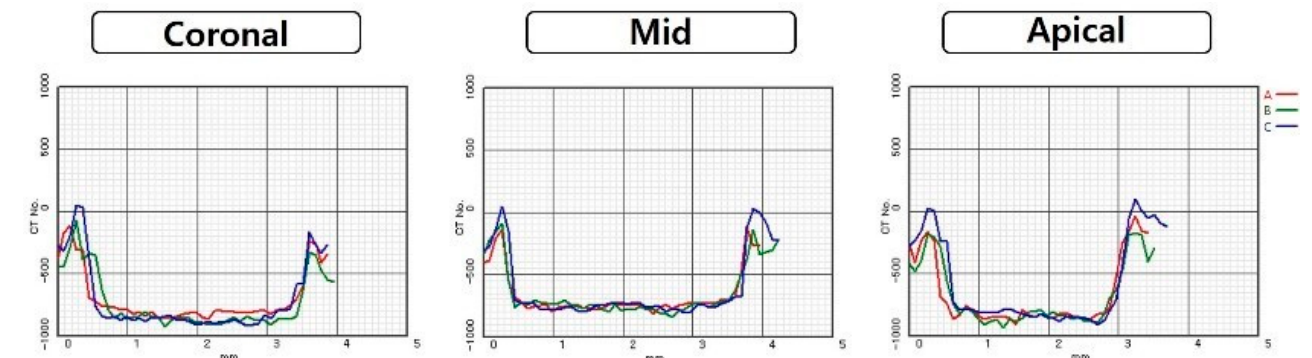
Figure 3. Comparison of Hounsfield unit gaps according to area at 3.8 mm diameter of conventional technique and 3.5 mm diameter of osseodensification technique: (A) conventional technique; (B)